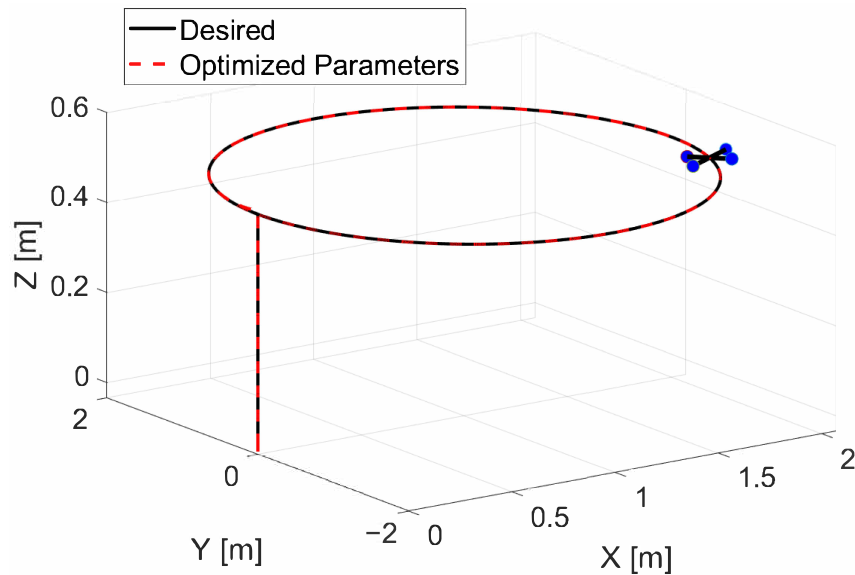
Figure 14. Tracking performance in three–dimensional space changing desired